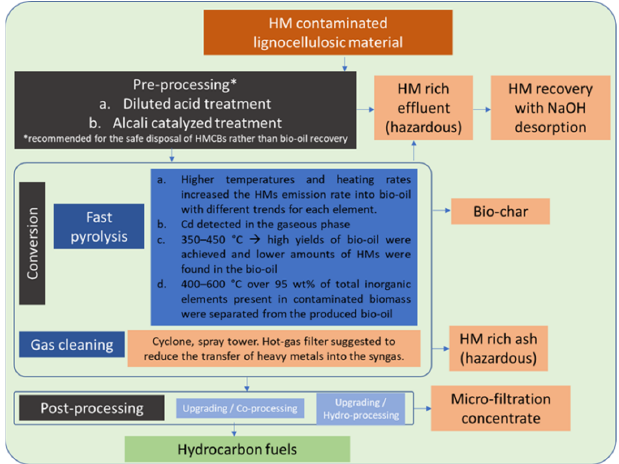
Figure 13. CVC3–BtL via pyrolysis. Adapted clean value chain.